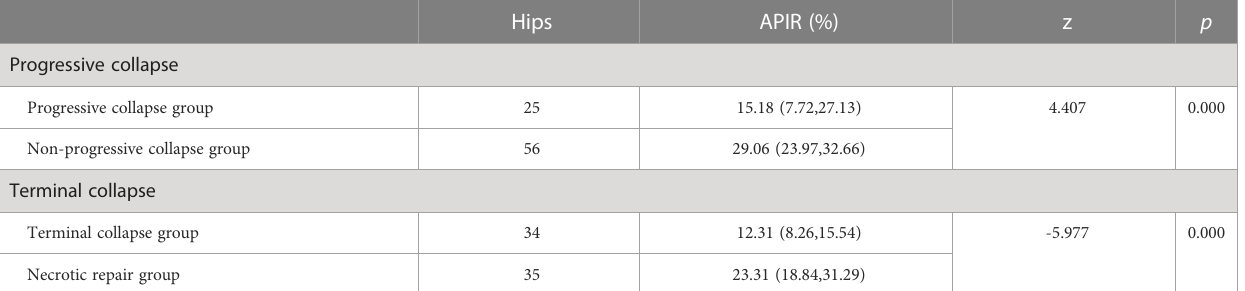
TABLE 2 The correlation between APIR and collapse.